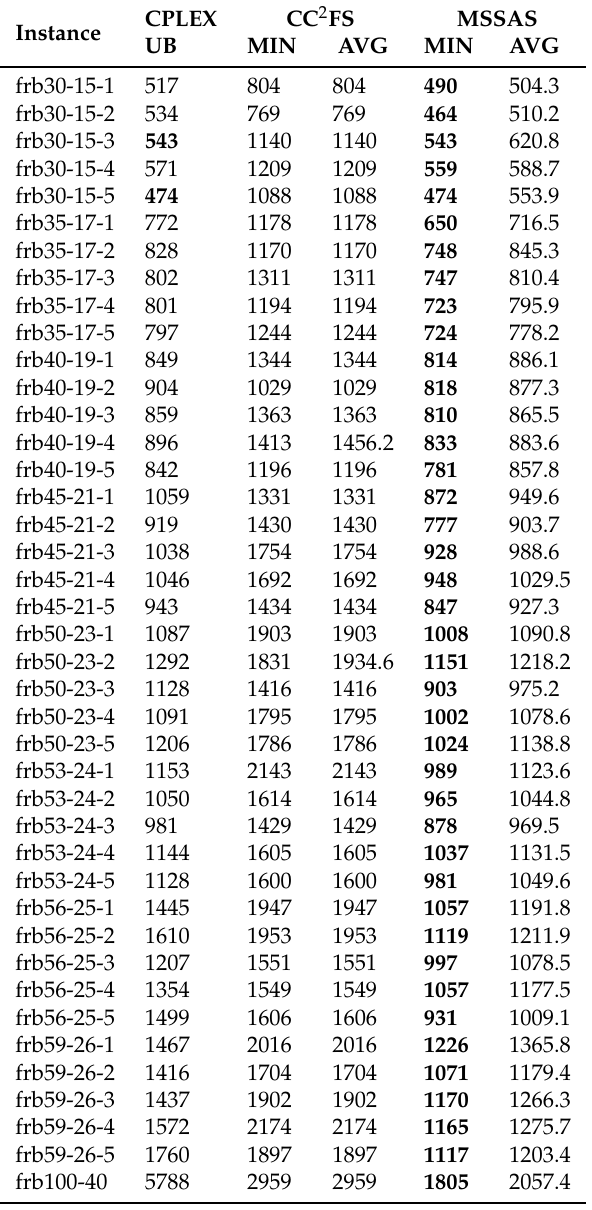
Table 4. Experimental results of CPLEX, CC 2 FS and MSSAS